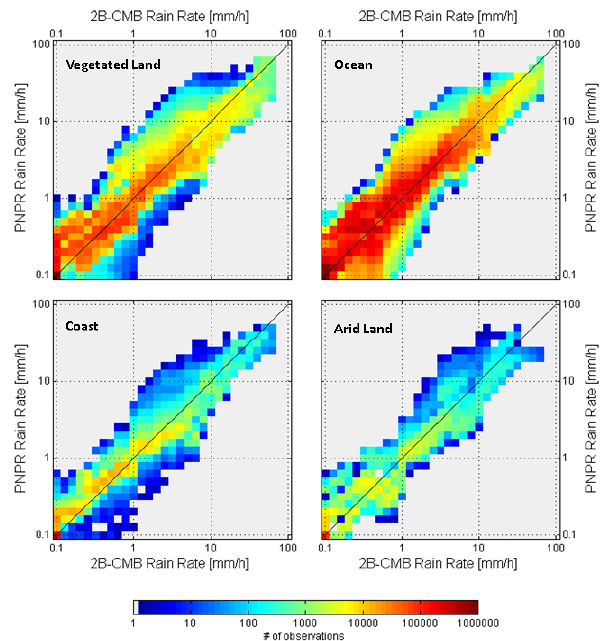
Figure 3. Density scatter plots of pixel based comparison of surface rain rate estimates from PNPR v3 and 2B-CMB (see Table 1) over different surfaces: vegetated land ( top left ), ocean ( top right ), coast ( bottom left ) and arid land ( bottom right ). Only pixels where both PNPR v3 and 2B-CMB provide liquid precipitation (hits) are shown.